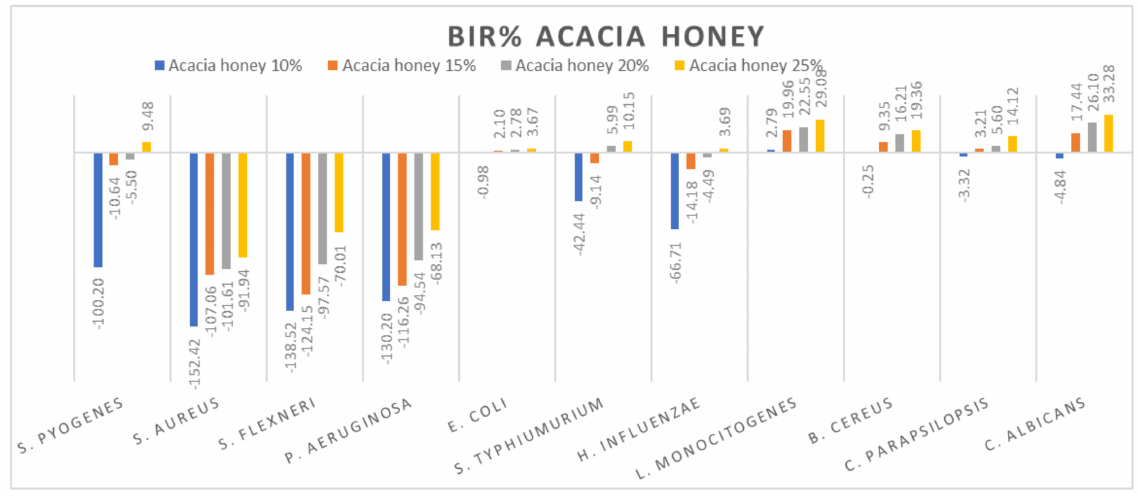
Figure 8. Acacia honey antimicrobial activity (expressed as BIR%/MIR%) on ATCC